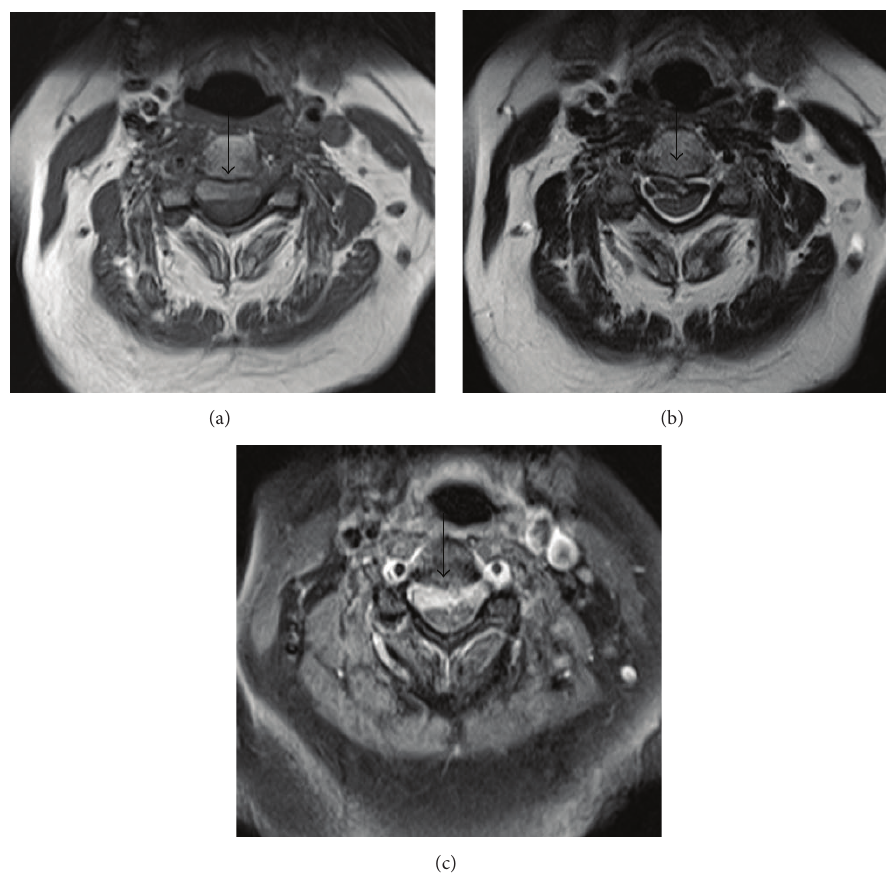
Figure 3: Axial images of the cervical vertebral column: (a) T1 weighted and (b) T2 weighted images showing an intradural extramedullary mass(arrow)occupyingtheanteriorintraduralspace,compressinganddisplacingthespinalcordposteriorly.(c)Onpostcontrastfatsaturated T1 weighted images the lesion shows peripheral heterogeneous